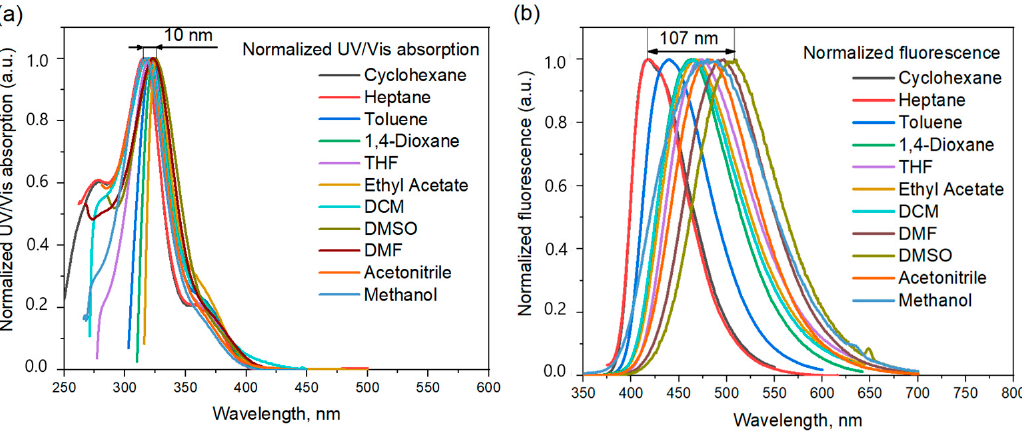
Figure 4. UV/Vis ( a ) and fluorescence ( b ) spectra of 3i in different solvents at room temperature.